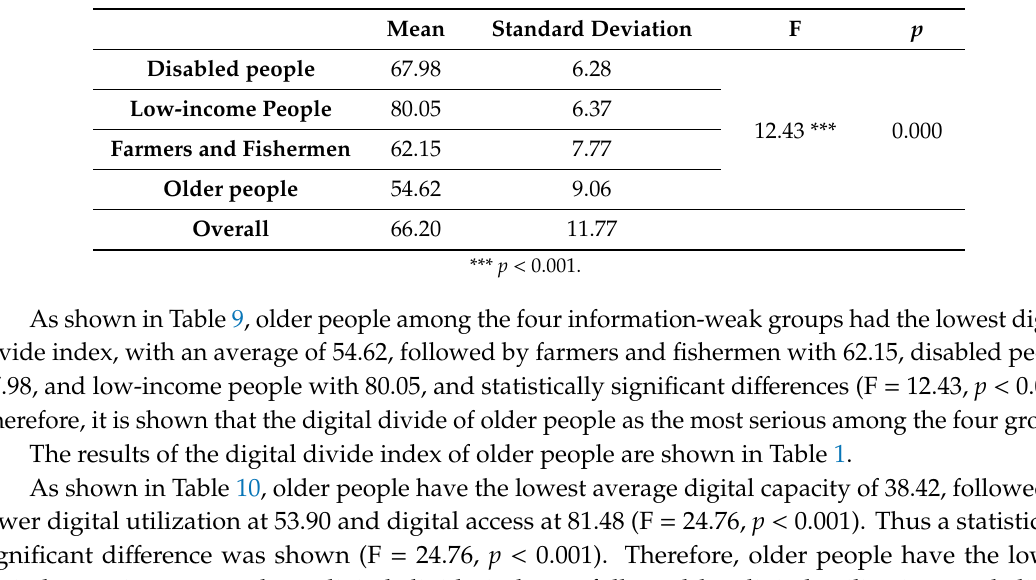
Table 9. Summary of digital divide of four classes.